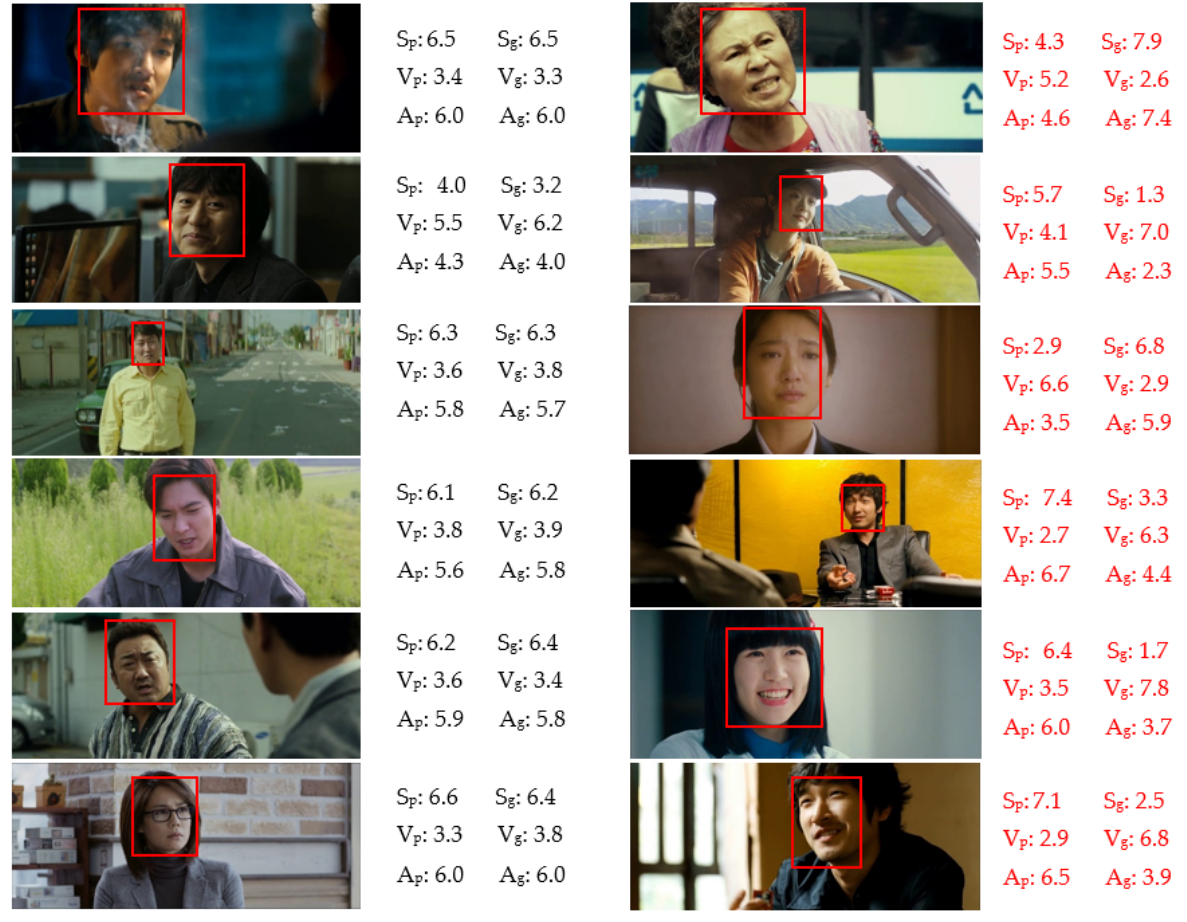
Figure 9. Ground truth and results on clips for stress recognition (Sp: prediction stress; Vp: prediction valence; Ap: prediction arousal; Sg: ground truth stress; Vg: ground truth valence; Ag: ground truth arousal).